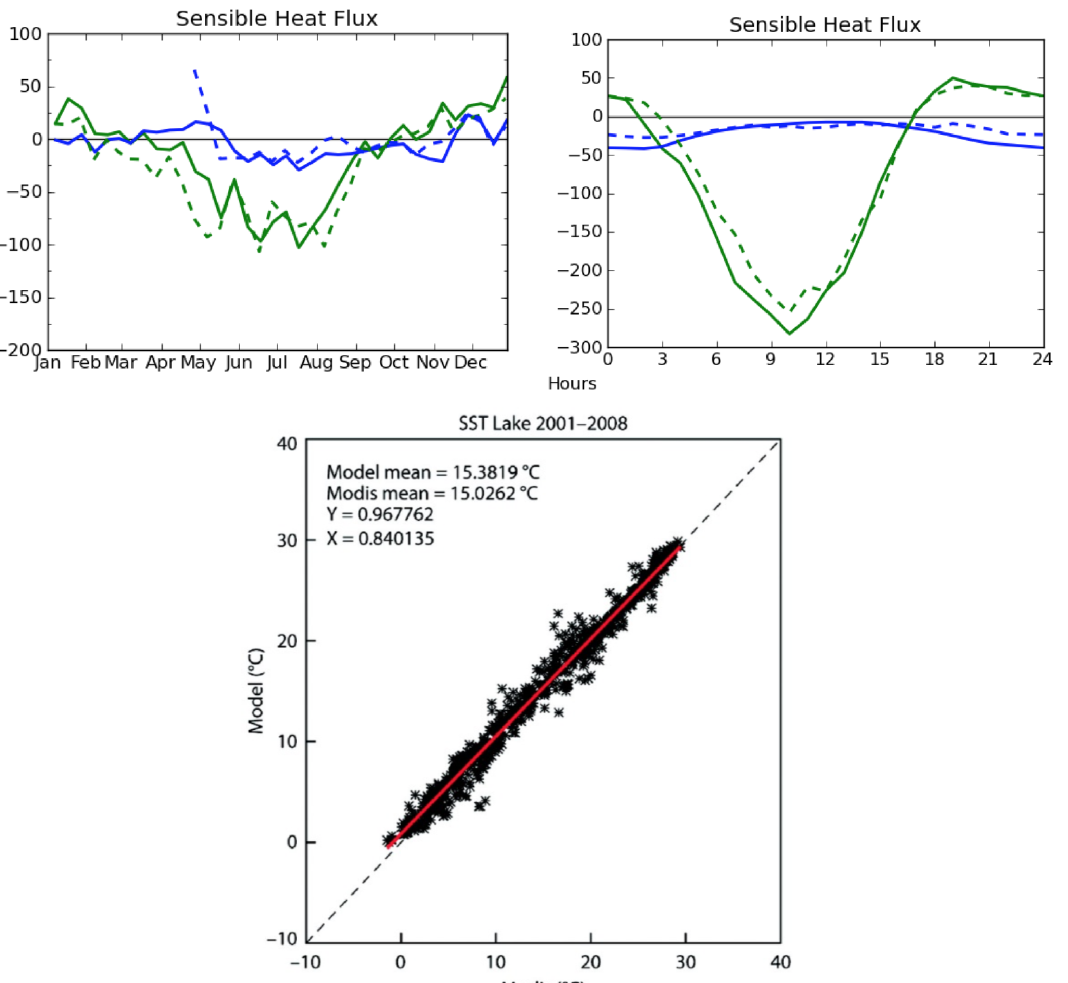
Figure 20. Sensible heat-flux over a lake (blue line) and a near-by forest (green line) in Finland. An annual cycle (upper left) and a mean July diurnal cycle (upper right) are shown for the model (solid line) and the flux-tower observations (dashed line), with a negative sign indicating an upwards heat transfer. Lake surface temperature on global scale simulated by the model FLake and observed with MODIS